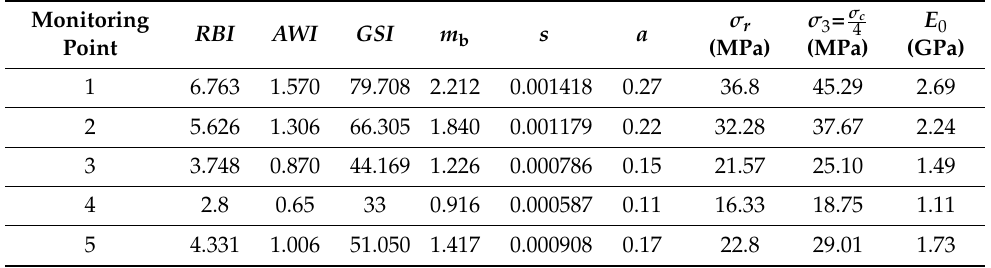
Table 6. Basic parameters of the surrounding rock mass at each monitoring position.